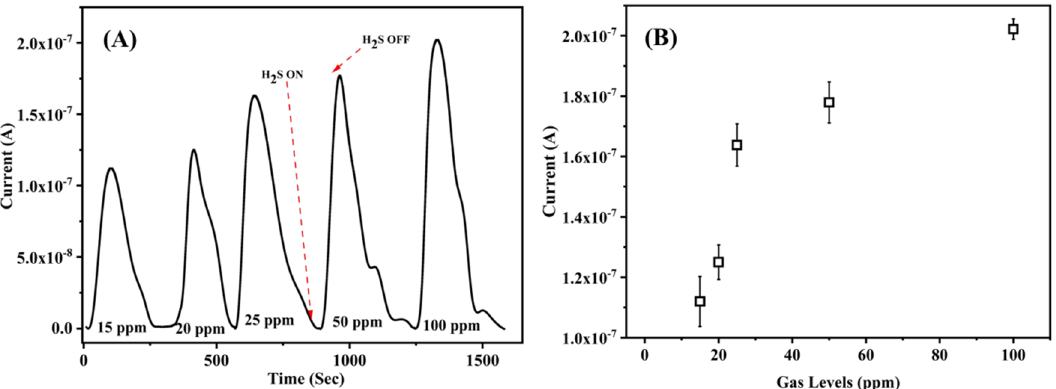
Figure 5. ( A ) Current response of ZnO/PVA/IL membrane to H 2 S gas exposure at different concen ‐ trations with respect to time. ( B ) The current response of the membrane as a function of gas concen ‐ trations.